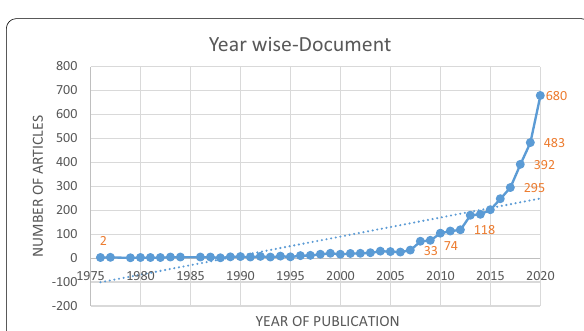
Fig. 3 Articles published from 1976 till 2020 . Note The graph